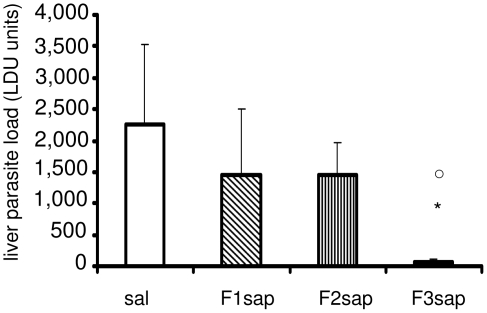
Long-term protection generated by the F3sap vaccine.Balb/c mice were vaccinated with NH36sap, F1sap, F2sap or F3sap at the indicated time intervals, through the sc route, followed by the intravenous challenge with L. chagasi amastigotes 28 days after the last immunization. Bars represent the mean ± SD of the individual parasite load in liver measured by LDU (one experiment, n = 3–4 mice). *p<0.05 significant differences from the saline controls and ○ from the F2sap vaccine.